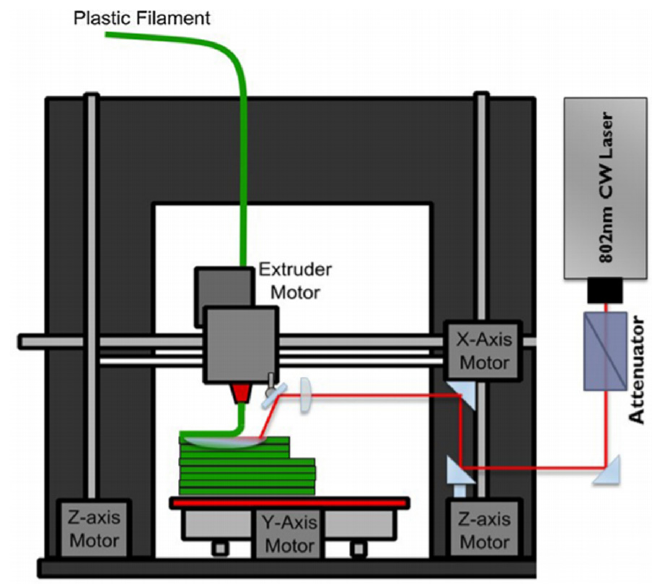
Figure 1. FFF printing using pre-deposition laser heating [7].